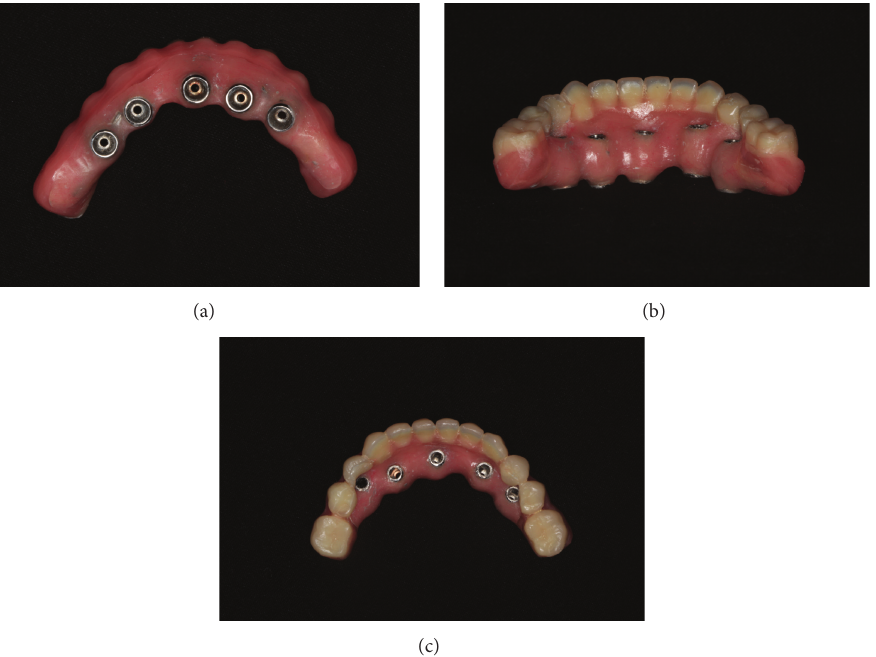
Figure 11: Mandibular denture after capturing the titanium cylinder and distal bar.